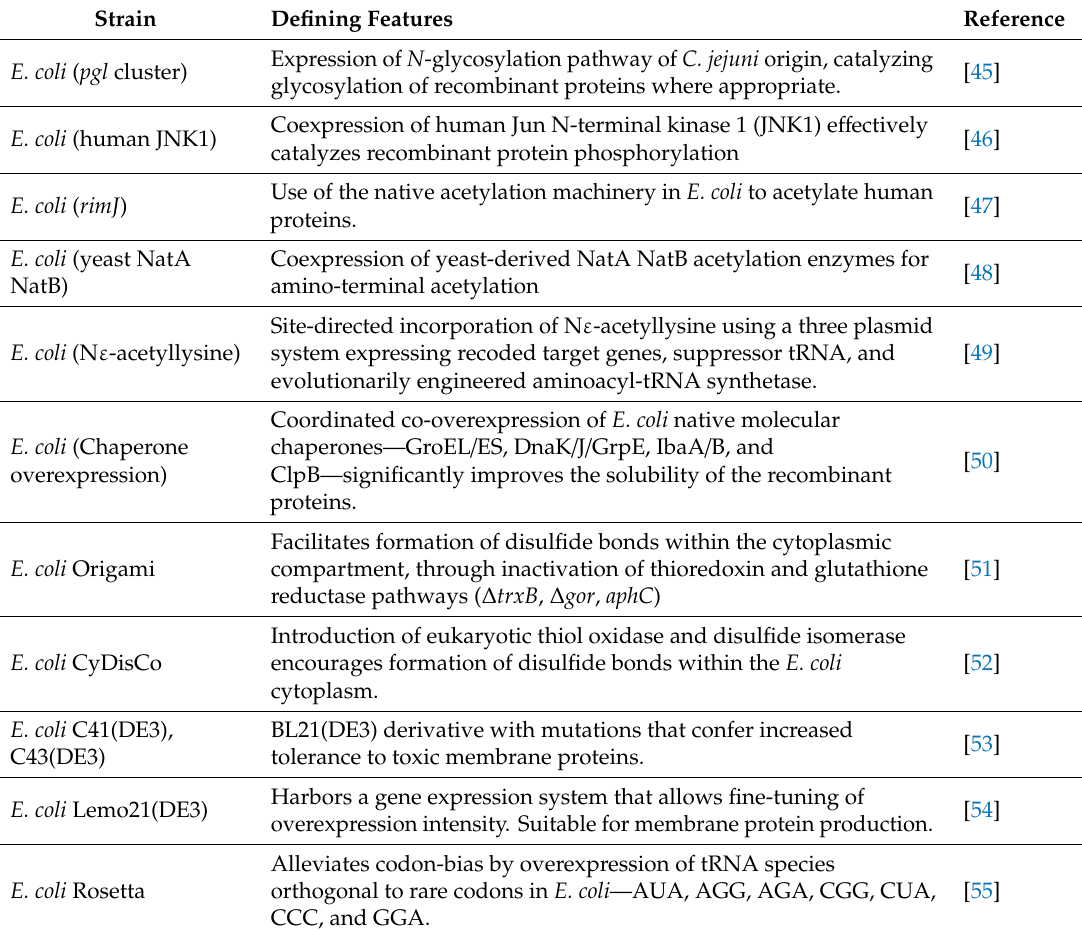
Table 1. Examples of prokaryote-based heterologous expression systems. Strain Defining